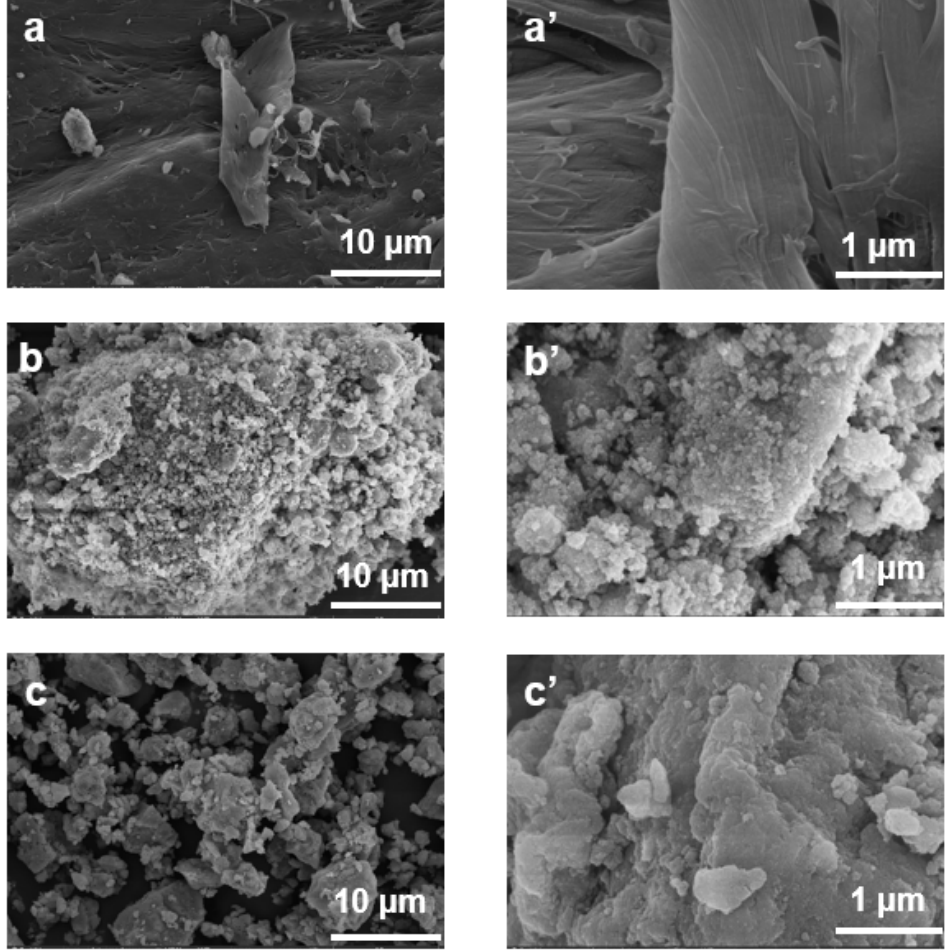
Figure 2. ESEM micrographs of ( a , a’ ) chitosan, ( b , b’ ) Fe 3 O 4 nanoparticles, and ( c , c’ ) MCN at lower (10 µm) and higher (1 µm) magnification.